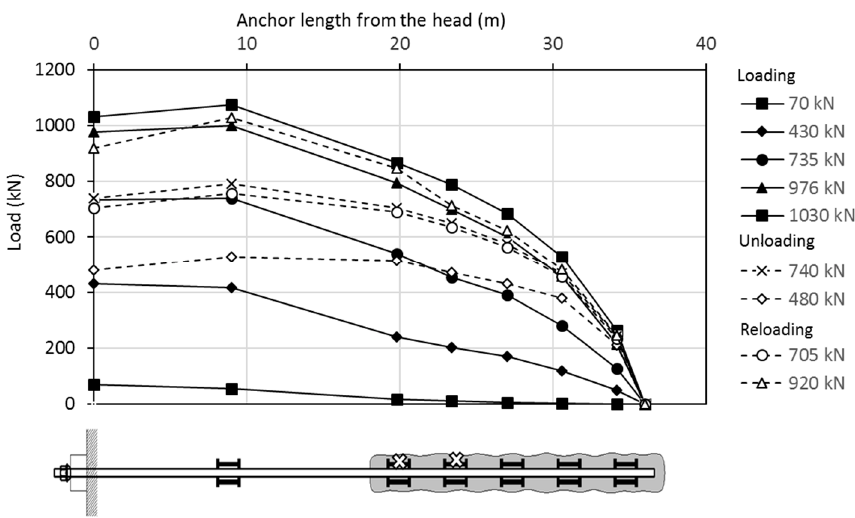
Figure 6. Distribution of the tensile force along anchor T1.